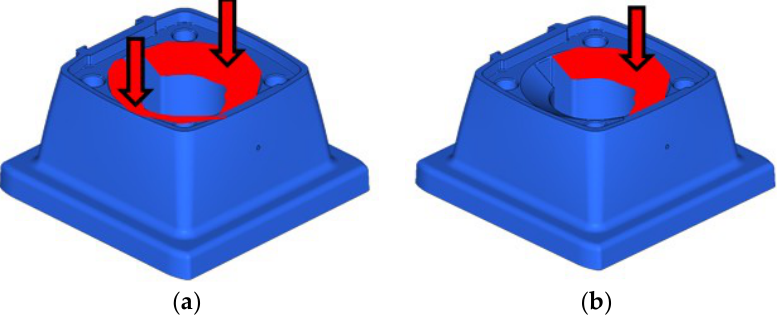
Figure 9. Case study part (support, in blue) with load in the conditions of: ( a ) Valve totally open; and ( b ) valve totally closed. Table 6. Mechanical properties of Novamid ® ID1070.